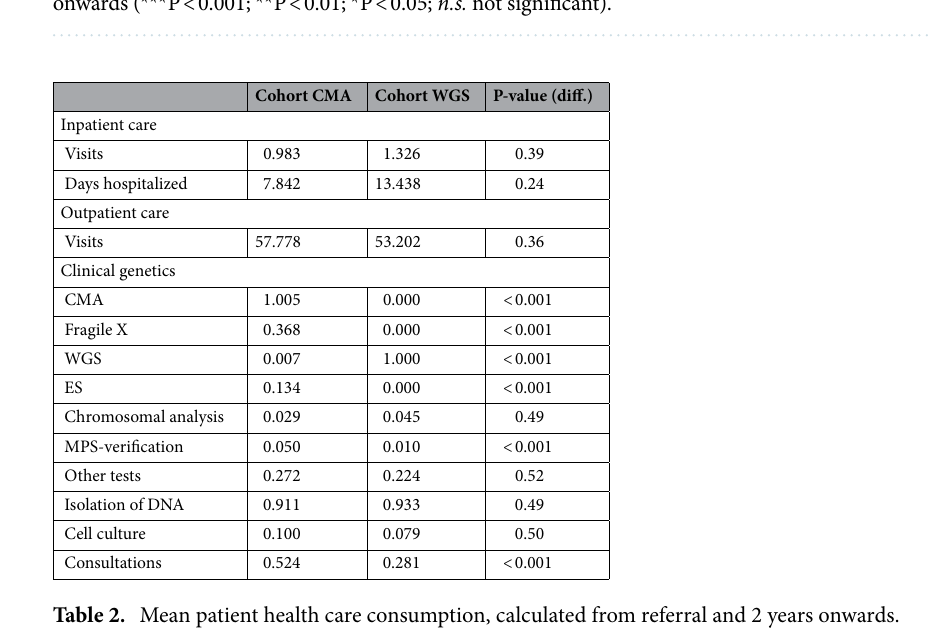
Figure 2. Mean patient costs ($) for each cohort calculated from referral for CMA/WGS testing and 2 years onwards (***P < 0.001; **P < 0.01; *P < 0.05; n.s. not significant).